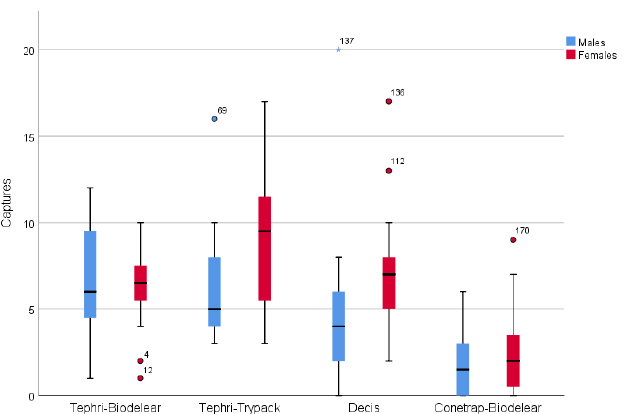
Figure 3. Box plot (horizontal line = medians; box = quartiles; vertical line = Q1 – 1.5 × (inter quartile range) and Q3 + 1.5 × (inter quartile range); dots = outliers; asterisk = extreme outliers) depicting the number of males and females caught in the four trapping devices in the semi ‐ field cage trials.